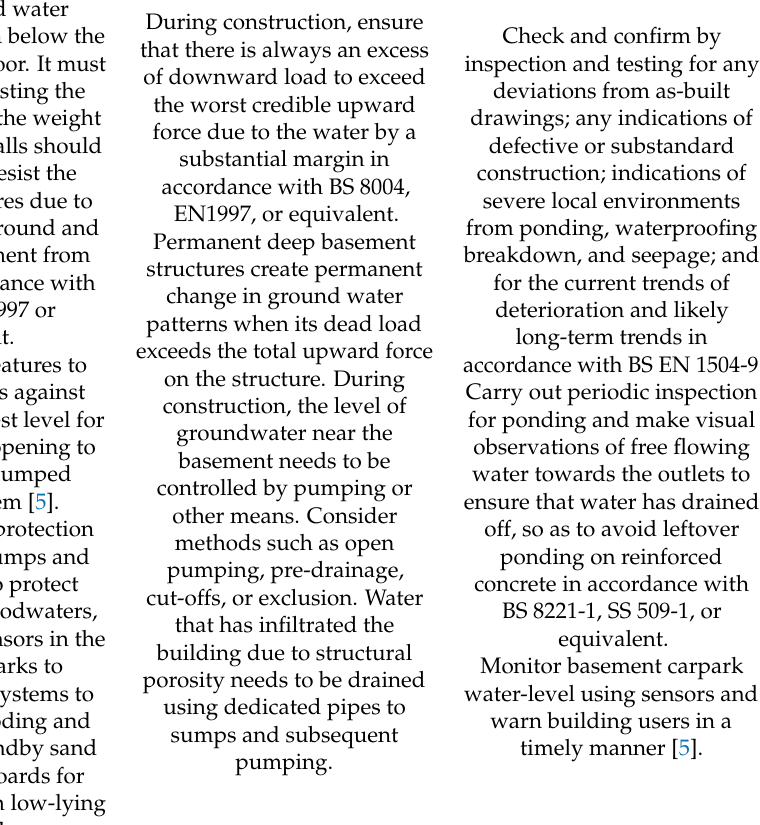
Table 3. Basements—Architectural components e.g., finishes, furnishings, and other elements that contribute to the aesthetic value and liveability.